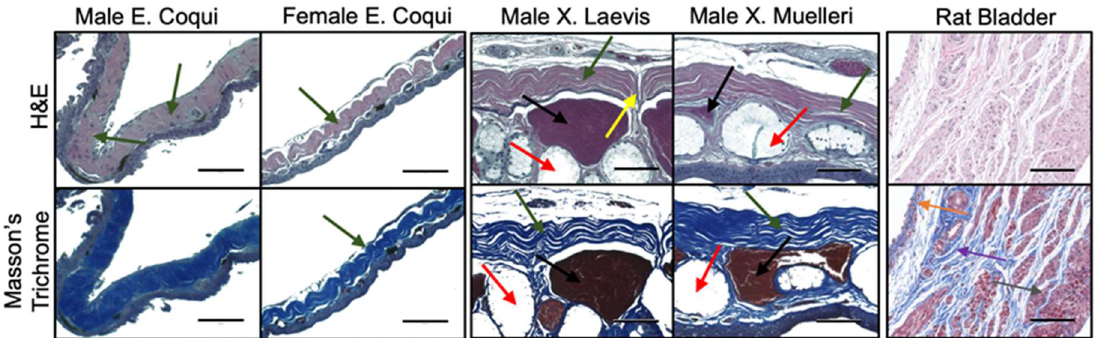
Figure 3. Tissue morphology by histology of gular tissue dissected from various species of frogs. Scale bar 100 µm. Muscle bundles (black arrows), mucous glands (red arrows), collagen structure (green arrows), perpendicularly aligned collagen (yellow arrows), urothelium (orange), lamina propria (purple), and detrusor muscle (grey).